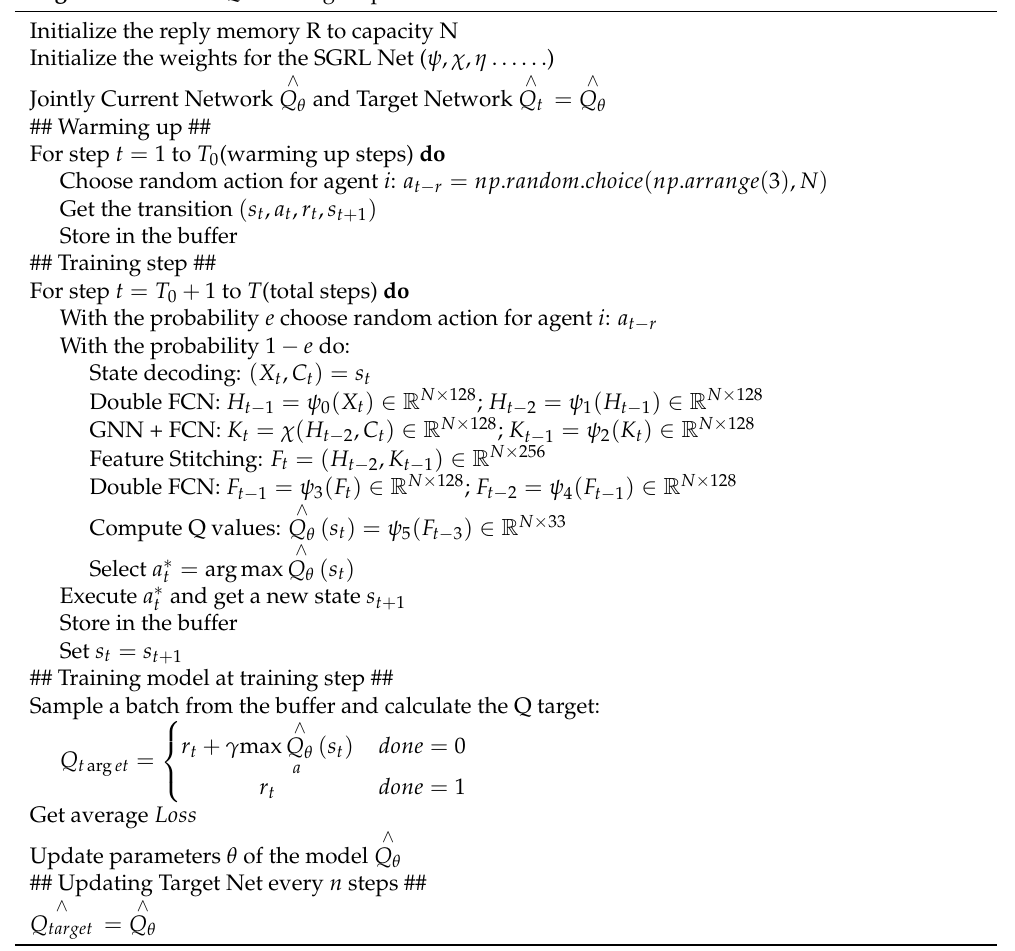
Figure 8. Scenario random setting diagram. Algorithm 1 shows the detailed steps of training. Algorithm 1 SGRL Q Learning